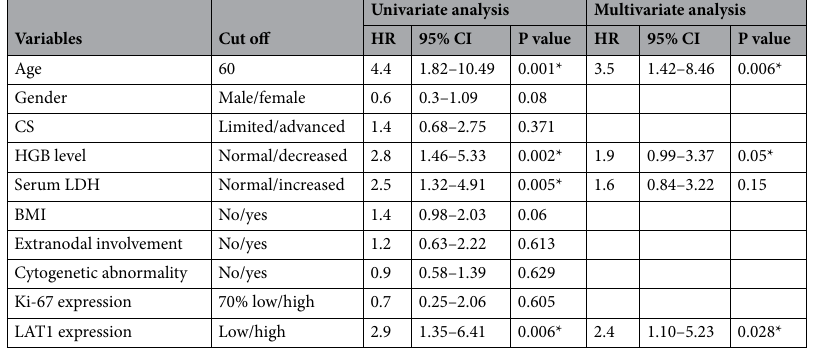
Table 5. Cox hazard analysis of overall survival in NHLs (n = 138). BMI, bone marrow involvement; CI, confidence interval; CS, cancer stage; HGB level, hemoglobin level; HR, hazard ratio; serum LDH, serum lactate dehydrogenase. *P-value < 0.05 indicates a significant